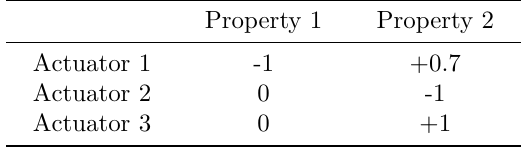
Table 1: Simulated interactions between the different actuator sets and properties.